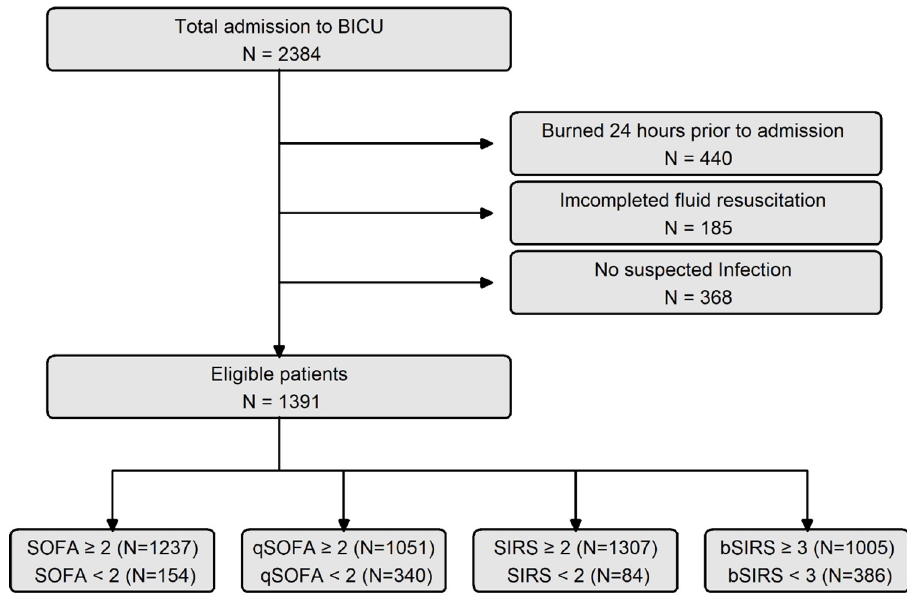
Fig 1. Flowchart of enrolled patients for the survival analysis in this